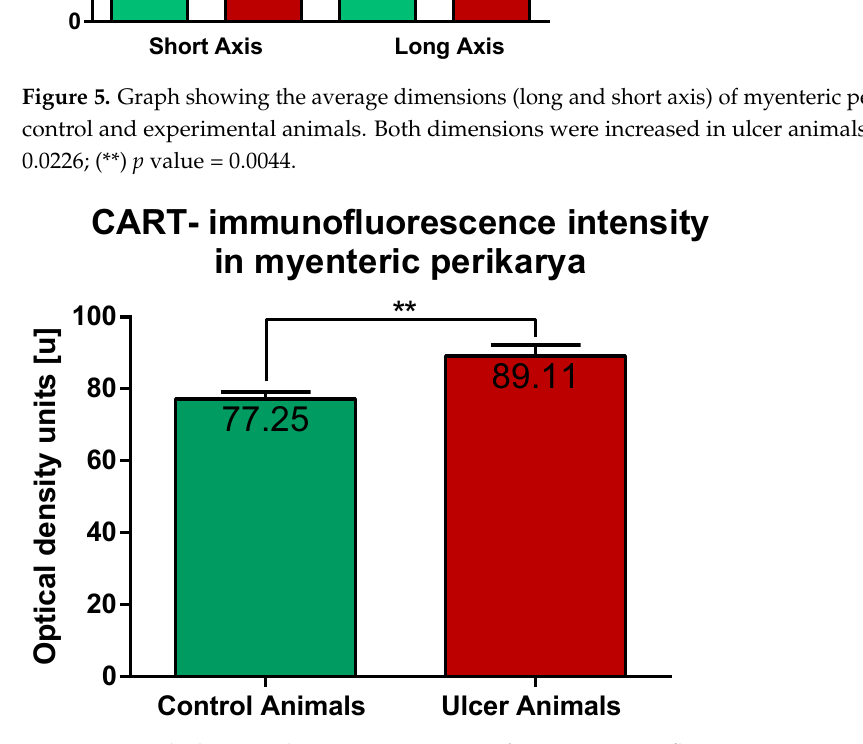
Figure 6. Graph showing the average intensity of CART-immunofluorescence expressed by control and experimental pigs’ myenteric perikarya measured with ImageJ software (ver. 1.53c, Rasband, W.S., National Institutes of Health, Bethesda, MD, USA) as a mean grey value inside the cell body area. The values are presented in optical density units. In ulcer animals the average intensity was higher than in control pigs. (**) p value = 0.006.